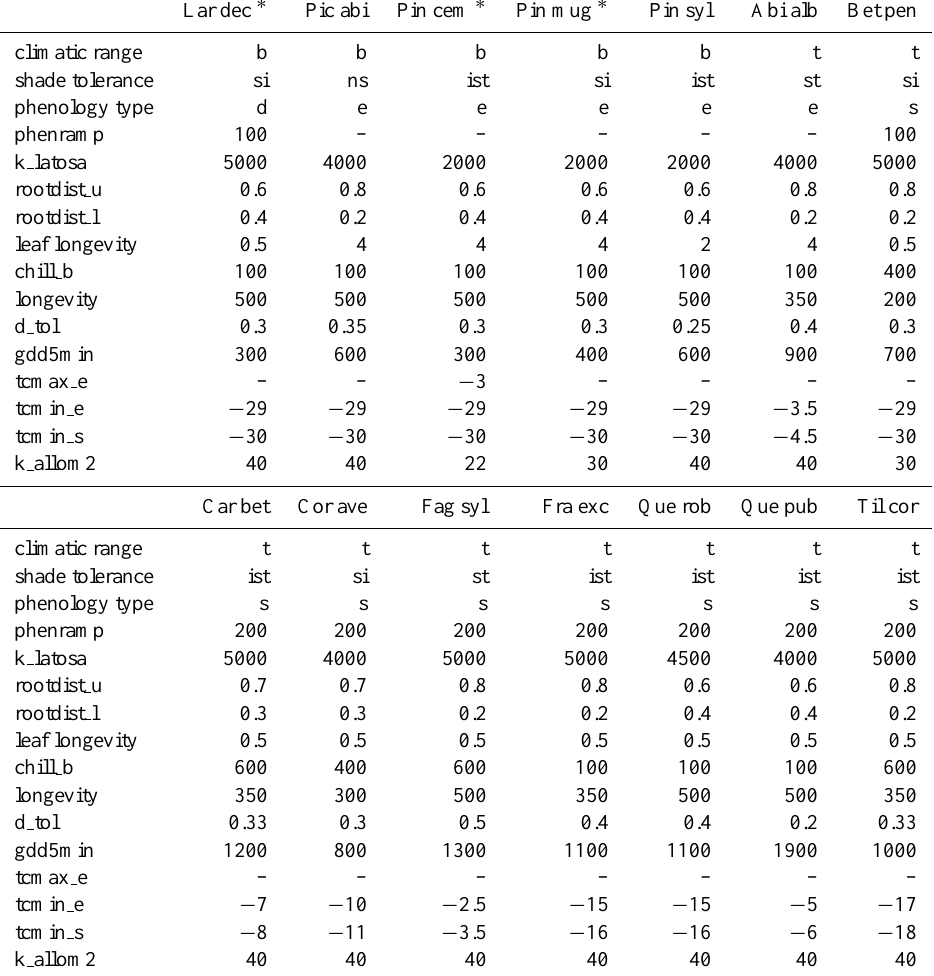
Table D3. Specific tree parameters. b: boreal; t: temperate; st: shade-tolerant; ns: nearly shade-tolerant; ist: intermediate shade-tolerant; si: shade-intolerant; e: evergreen; s: summergreen; d: summergreen with decelerated senescence; phenramp: growing degree sum on 5 degree base required for full leaf cover; k latosa: ratio of leaf area to sapwood cross-sectional area; rootdist u and rootdist l: proportion of roots extending into upper and lower soil layer; chill b: changed chilling parameter (Sykes et al., 1996); d tol: drought tolerance, lower values show higher tolerance (minimum soil water content needed for establishment, averaged over the growing season and expressed as a fraction of available water holding capacity, and water uptake efficiency); gdd5min: minimum growing degree day sum on 5 ◦ C base, tcmax e and tcmin e: minimum and maximum 20-year coldest month mean temperature for establishment; tcmin s: maximum 20-year coldest month mean temperature for survival; k allom2: steepness-influencing parameter in diameter to height relation. longevity and leaf longevity are in years. Lar dec: Larix decidua ; Pic abi: Picea Abies ; Pin cem: Pinus cembra ; Pin mug: Pinus mugo ; Pin syl: Pinus sylvestris ; Abi alb: